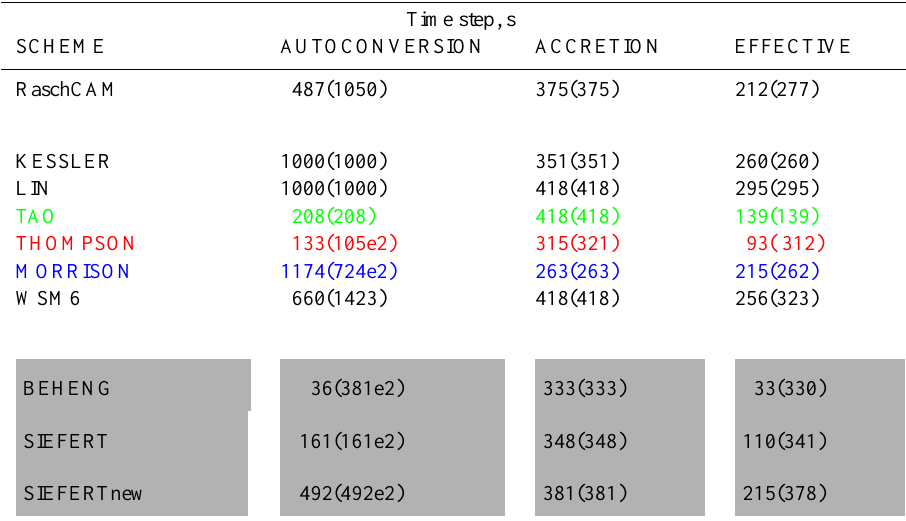
Table 1. Maximal time steps permitted to keep explicit Eulerian time integration scheme stable and positive-definite for autoconversion, accretion, and due to both processes in CAM and WRF bulk microphysics schemes. For comparison, the same values for Beheng (1994), Seifert and Beheng (2001), and Seifert and Beheng (2006) parameterizations are presented in gray. Maximal time steps shown for Q c